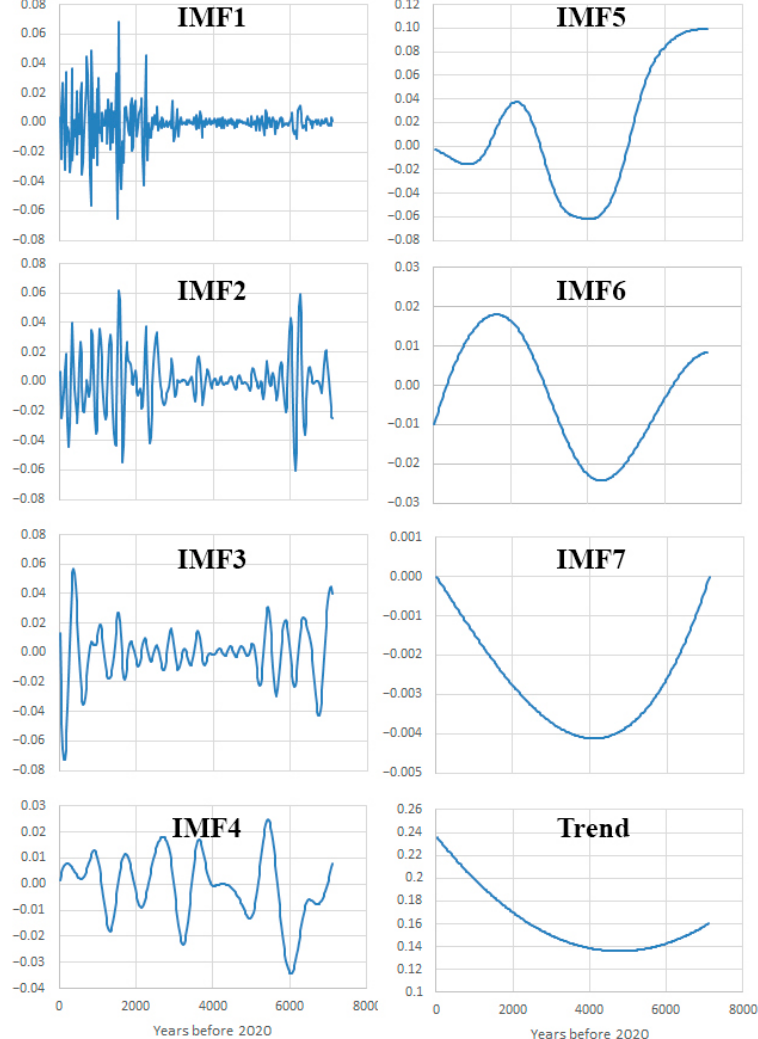
Figure 4. EEMD of the reconstructed humification timeseries in seven IMFs and a trend. Figure 4 . E EMD of the reconstructed humification timeseries in seven IMFs and a trend.